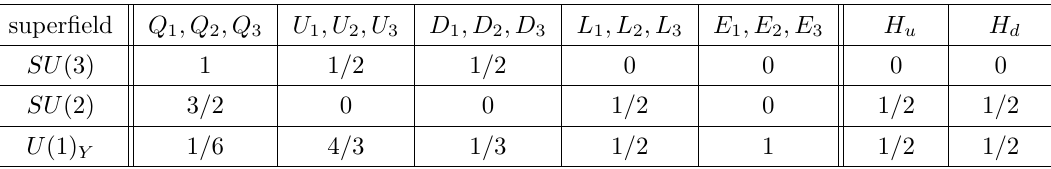
Table 2 . T a K for various MSSM superfields. The superfields are numerated by the subscript a, and K = SU (3) , SU (2) , U (1) .